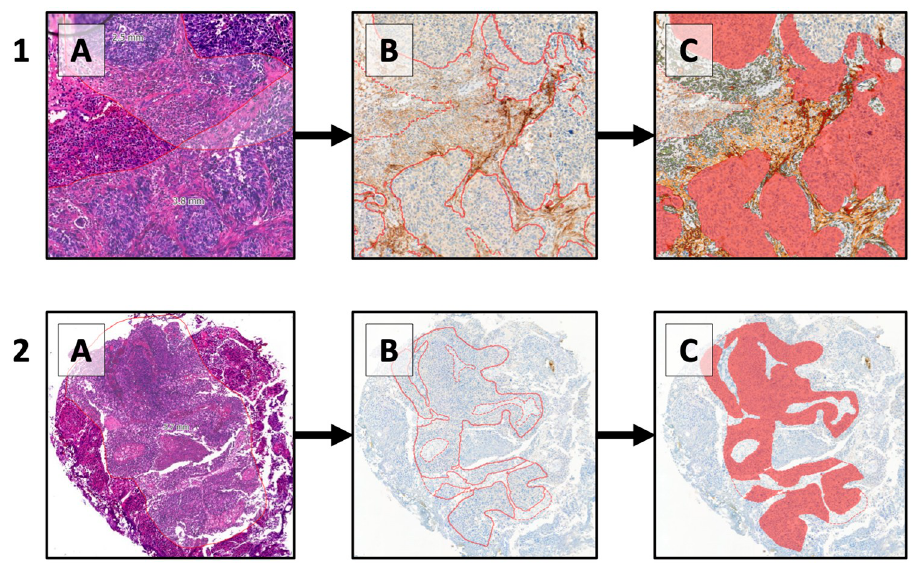
Fig 1. Patient 1 and patient 2: Illustrative figure of the analytical workflow. Patient 1 shows high FAP expression and patient 2 shows absent FAP expression. A: T1 tumour regions of interest (ROI) within each patient were digitally annotated on a serial H&E-stained slide by an expert uro-pathologist (TG) within Pathomation digital pathology software. B: Digital annotations of ROIs were transferred from the H&E slides to the FAP-IHC slides with the image analysis software Visiopharm, and areas with tumour and stroma were separated. C: FAP expression was measured in the stromal areas only as relative marker area (RMA) with integration of low, medium and high expression levels (formula, calculated using Visiopharm: [RMA low FAP] + [RMA medium FAP] + [RMA high FAP]) (red coloured areas are omitted tumour areas). patients with a primary diagnosis of HG T1 with no prior NMIBC (primary T1; n = 71), and a secondary diagnosis of T1 with prior Ta and/or Tis NMIBC (secondary T1; n = 15). We con- structed a bivariable Cox proportional hazards model with FAP RMA in HG T1 ROIs, and adequate BCG (per Food and Drug Administration [FDA] definition: at least 5/6 doses of induction plus 2/3 doses of maintenance, or at least 5/6 doses of induction plus at least 2/6 doses of a second induction course; yes vs. no) for recurrence-free survival (RFS), PFS, cancer- specific survival (CSS), and overall survival (OS). CUETO progression score was not included in the model as our primary cohort was pair-matched using this score, and CUETO progres- sion scores remained balanced between groups following single pathologist revision of all slides and tissue quality assessment (p = 0.8) [9]. There was no significant difference in RFS (p = 0.08) or PFS (p = 0.8) when stratifying for presence of CIS (yes vs. no). Additionally, there was no correlation between FAP RMA in HG T1 ROIs and CUETO progression score ( ρ = -0.02; p = 0.8), and CUETO progression score was also not prognostic for PFS (p = 0.5), and RFS (p = 0.2). Interestingly, FAP RMA in HG T1 ROIs was prognostic for RFS, PFS, CSS, and OS in these bivariable models (for PFS: S2 Fig). CK5 and GATA3 were not prognostic for these endpoints in comparable bivariable models replacing FAP with either CK5 or GATA3. Adequate BCG, as defined by the FDA, only impacted RFS, but not PFS, CSS, and OS, which stresses the fact that FAP is indeed an independent prognostic variable for all endpoints. To visualize the impact of FAP RMA in HG T1 ROIs, we dichotomized FAP as a categorical vari- able and compared low vs. high using log-rank test with the median FAP RMA as cut-off (Fig 2). Additionally, we visualized PFS stratified by FAP RMA in T1 ROIs (low vs. high) and ade- quate BCG (yes vs. no), which suggested a potential predictive role of FAP (Fig 3). However, no significant differences in pairwise comparison were found in PFS in FAP low patients